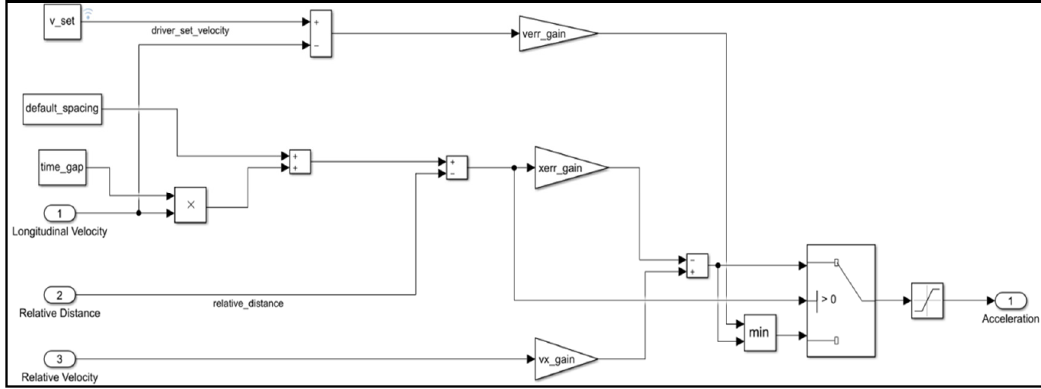
Figure 6. Structure of proportional-integral-derivative (PID) controller for ACC system .